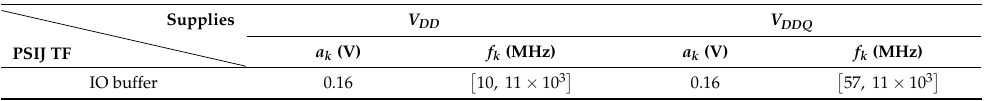
Table 7. Experimental settings of the frequency sensitivity of the PSIJ transfer function of the driver’s IO stages of results shown in Figure 11.